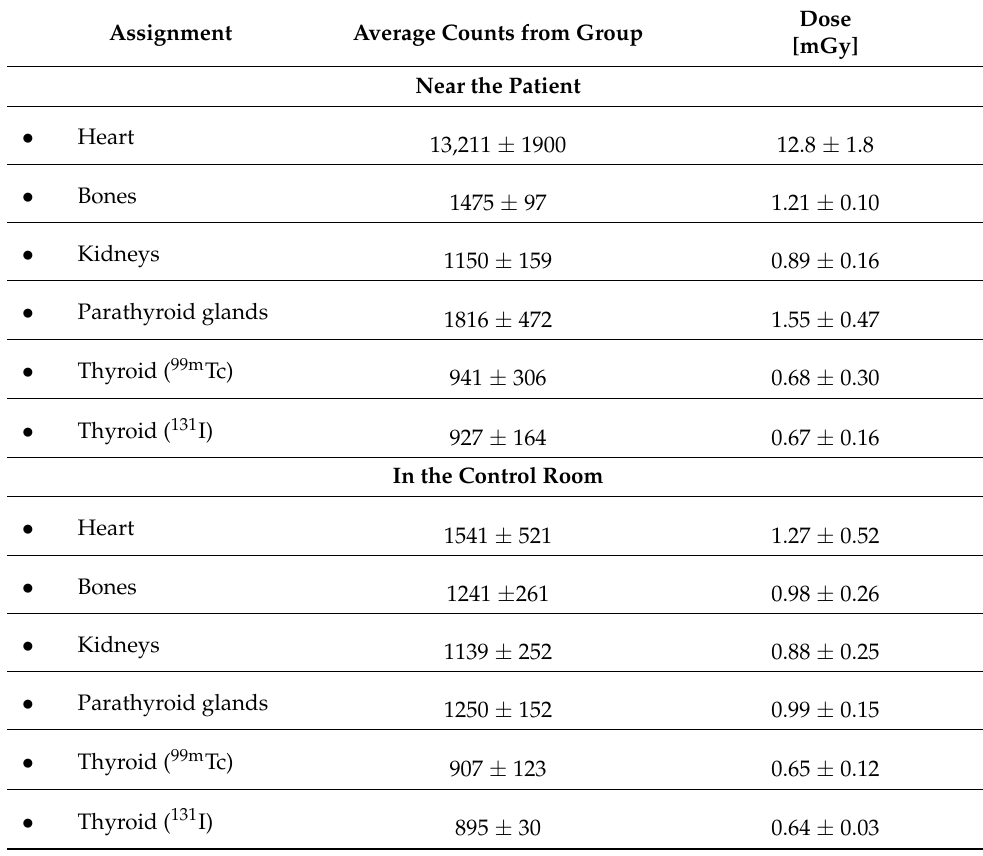
Table 1. The total doses absorbed at the point of interest for two- or one-month observation periods through TLD with their